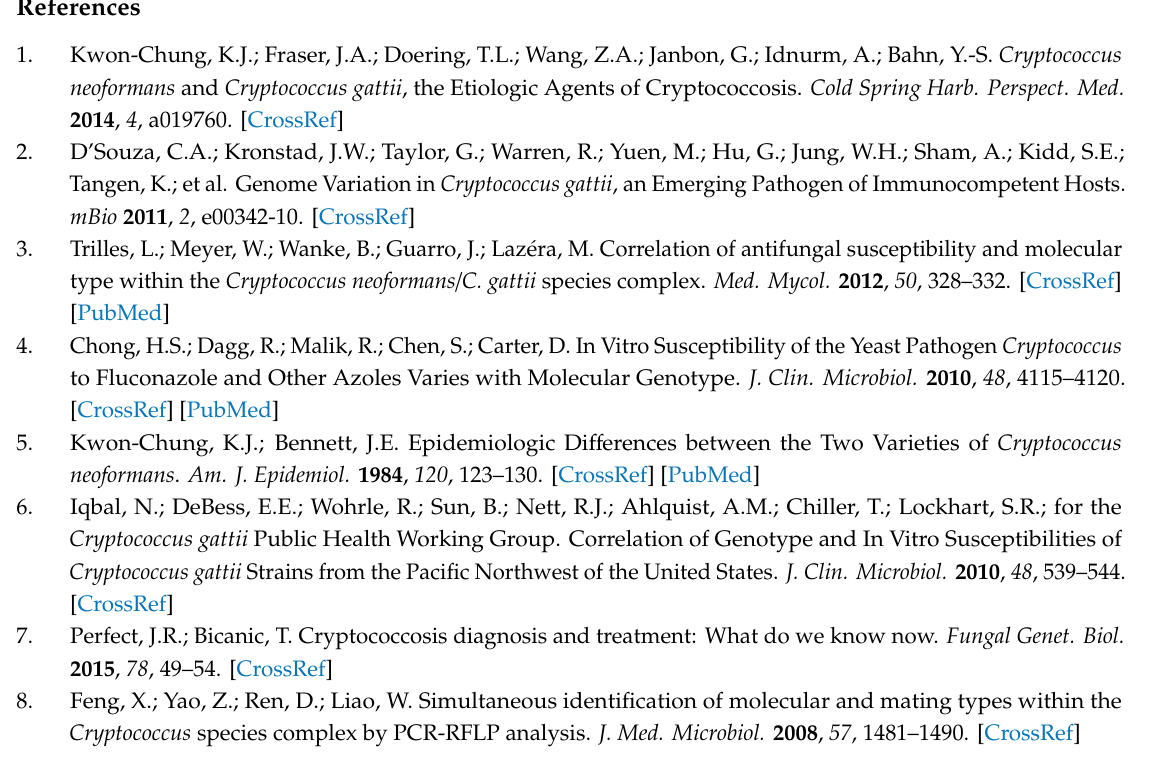
Table S1. Detailed information about the Cryptococcus strains included in this study. Table S2. Pre-treatment of raw data spectra for the biomarkers search. Table S3. Parameters applied for the construction of the peak matrix. Table S4. Score and validation of (A) the SVM analysis applied to the two-step model with 5 biomarkers and (B) PLS-DA applied to the one-step model with 5 biomarkers. K = 10 Figure S1. ROC curve of MS peaks of Cryptococcus spp. according to the criteria for the biomarkers search. Figure S2. Discrimination between C. neoformans and the interspecies hybrids using the two-step classification method. Figure S3. Representative protein spectra from the three Cryptococcus species analyzed in this study. Species-specific peaks with intensity above 500 arbitrary units (a. u.) are marked with asterisks (*). The complete list of species-specific peaks can be found in Table